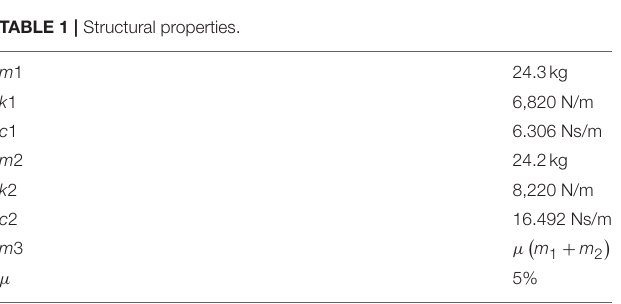
TABLE 1 | Structural properties.